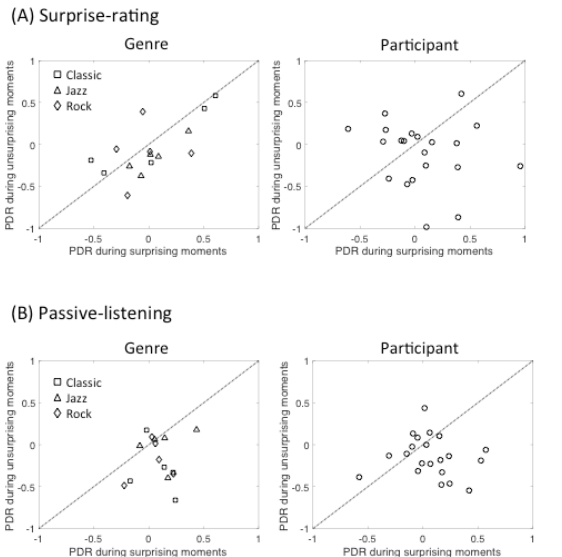
Fig. 3. Scatter plots of PDR during the surprising moments against PDR during the unsurprising ones in surprise-rating (A) and passive-listening (B) sessions. Each marker represents each musical genre (in the left panels) or participant (in the right